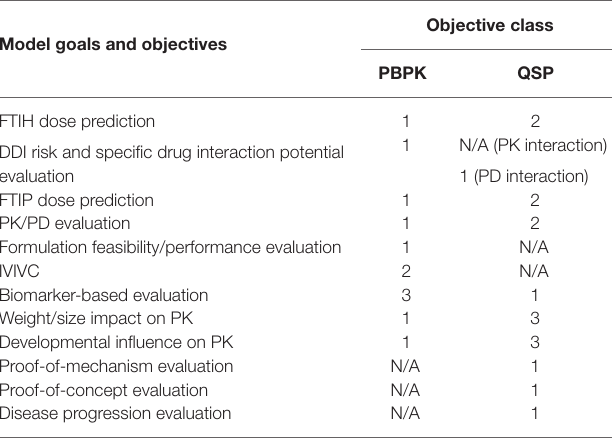
TABLE 1 | Typical goals and objectives for physiologically based pharmacokinetic (PBPK) vs. quantitative systems pharmacology (QSP) models.